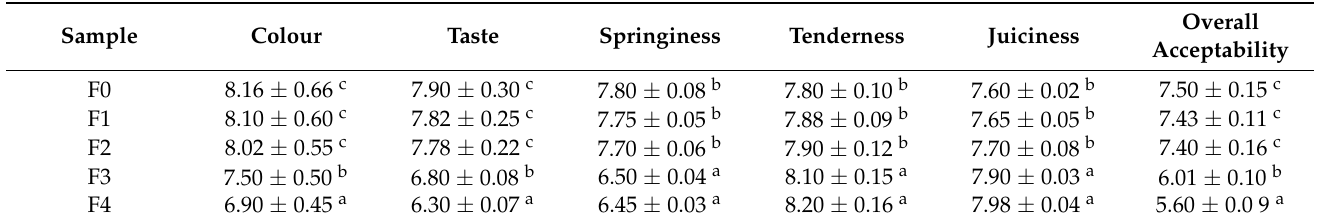
Table 6. Effects of MOLP on sensory analysis of cooked ground beef stored at 4 ± 1 ◦ C for 5 days.